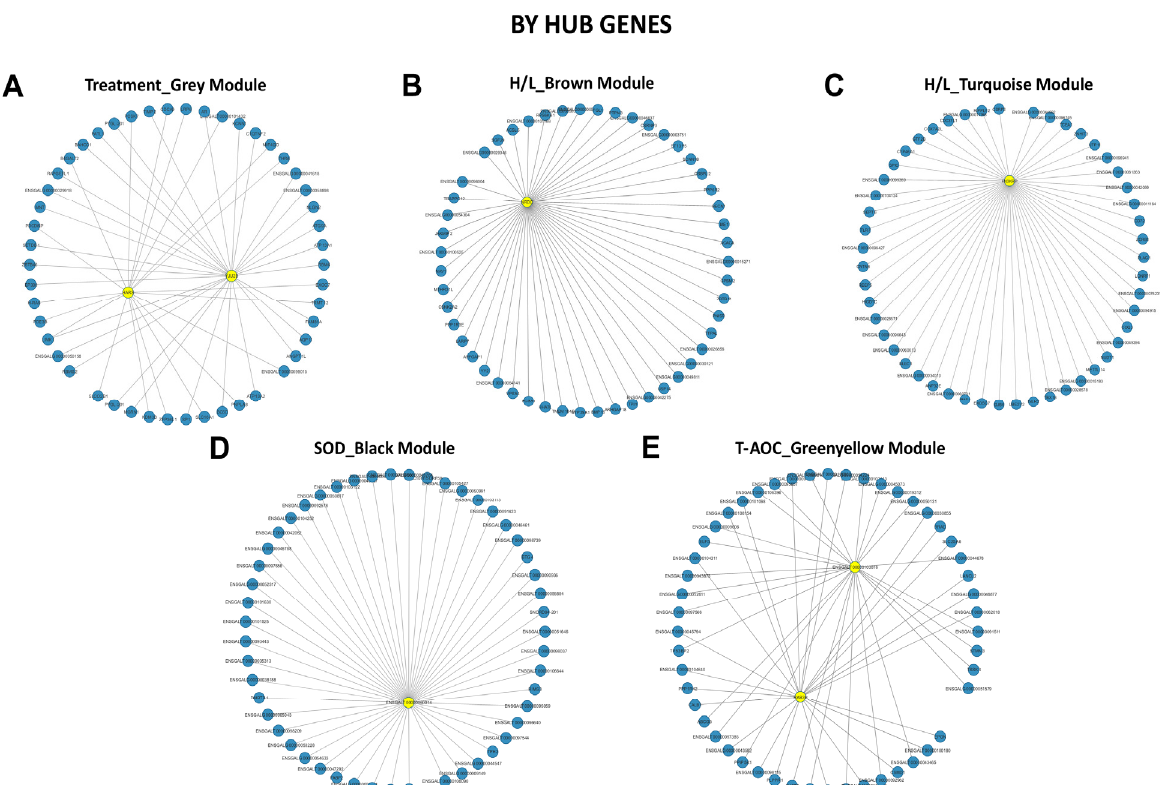
Figure 6. Co-expression network of hub genes in BY chickens: ( A ) Filtered co-expression network treatment grey module. ( B ) Filtered co-expression network H/L brown module. ( C ) Filtered co-expression network H/L turquoise module. ( D ) Filtered co-expression network SOD black module. ( E ) Filtered co-expression network T-AOC greenyellow module.